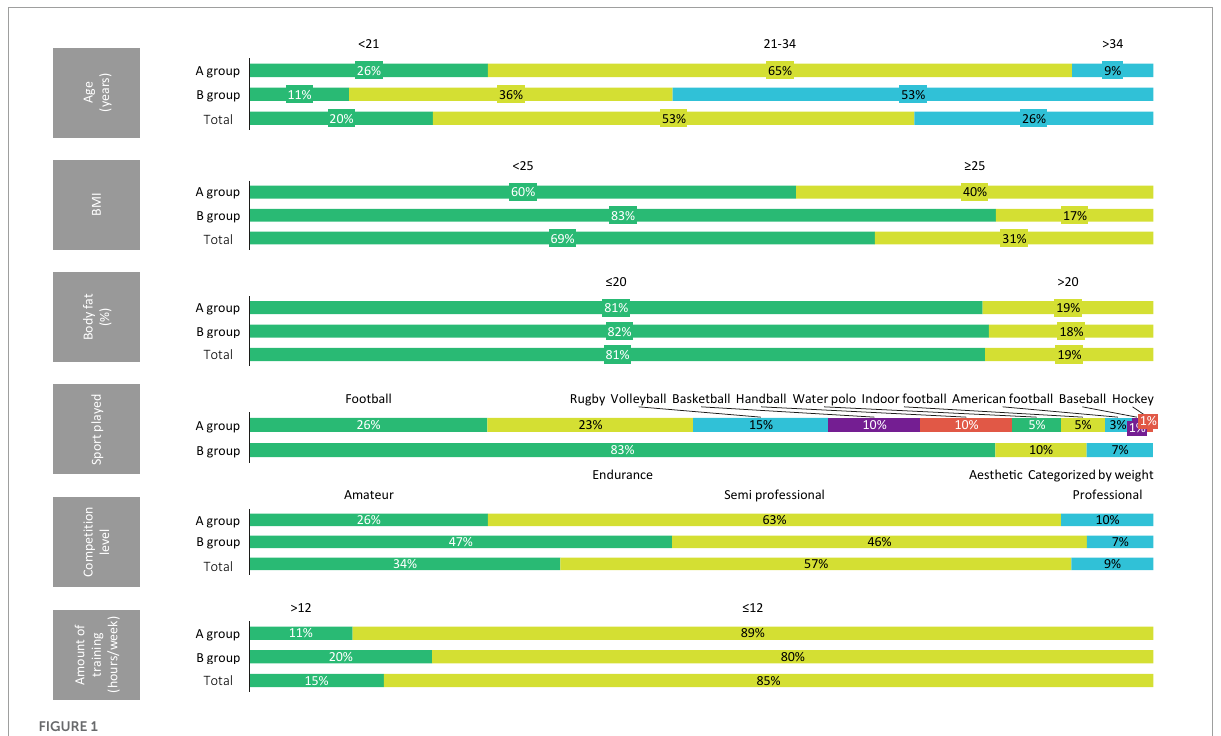
FIGURE1 Distribution of the sample according to the age, BMI, body fat, sport played, competition level, and amount of training.